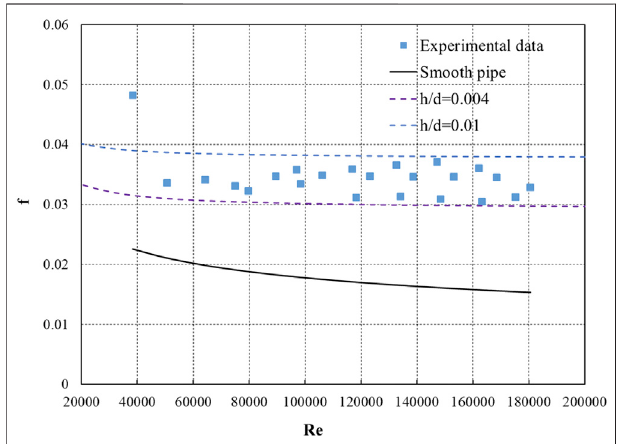
FIGURE 4 | Friction-factor ( f ) results at different Reynolds numbers (Re) from the NCCL